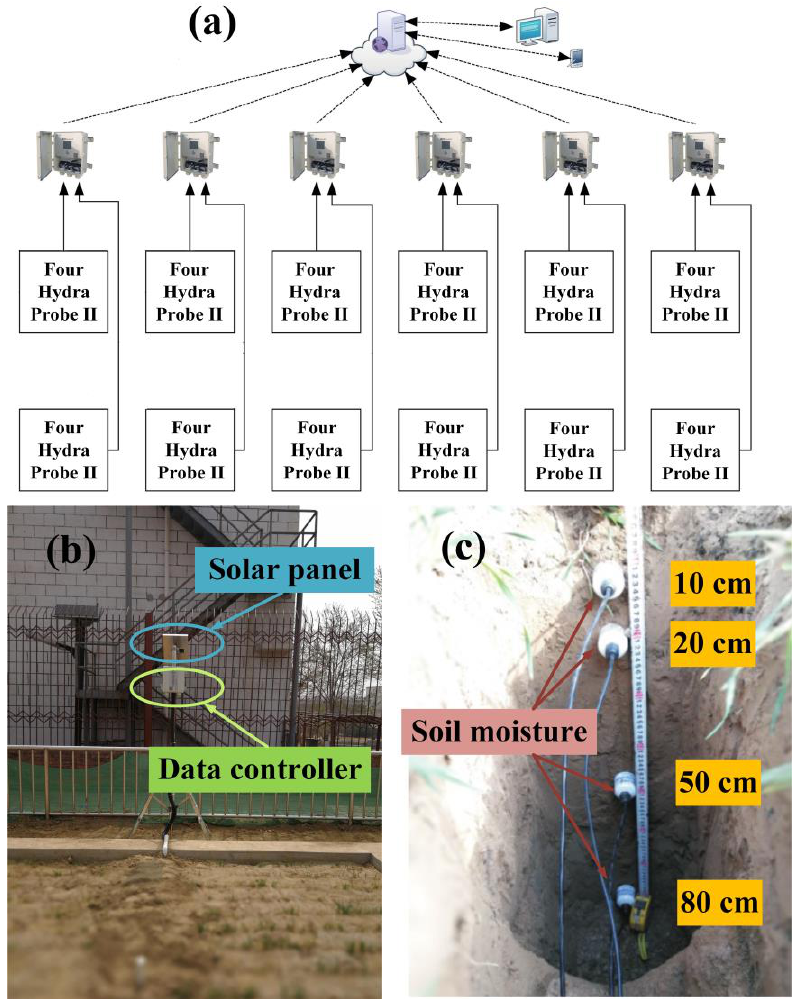
Figure 3. ( a ) Soil moisture monitoring system; ( b , c ) are the components of the soil moisture monitoring system. It mainly includes solar panel, data collector and soil moisture sensors. The sensors were installed in each plot at depths of 10, 20, 50 and 80 cm below the surface.